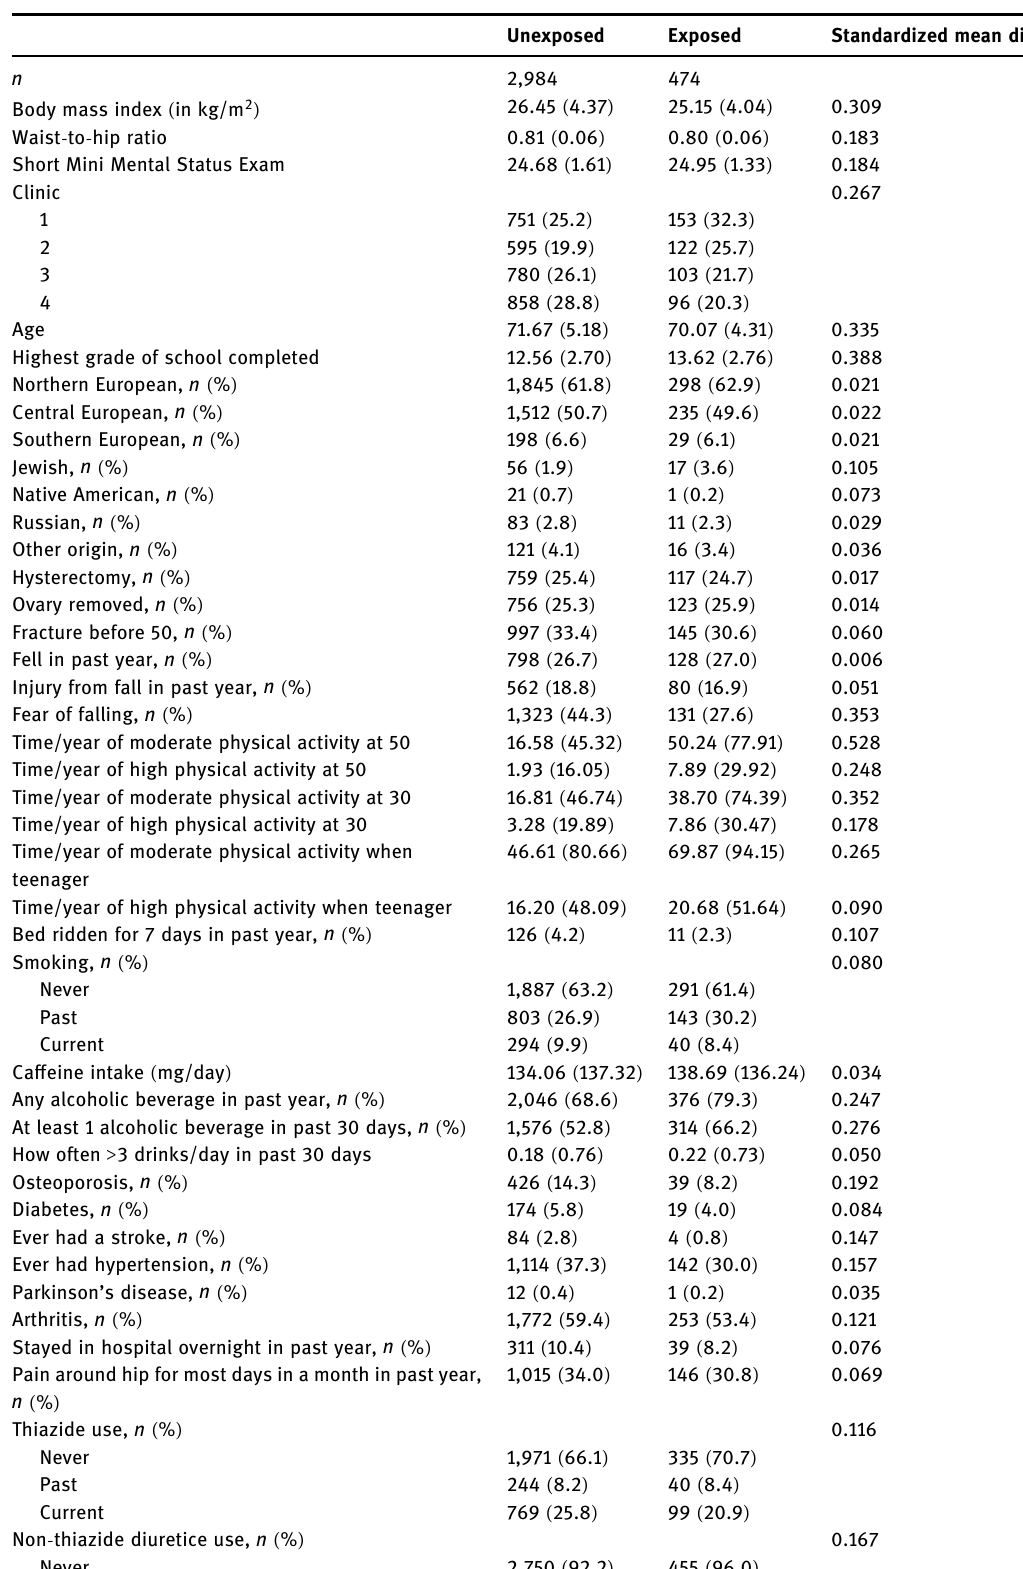
Table A13: Descriptive characteristics of the participants in the study of osteoporotic fractures according to exposure to physical activity